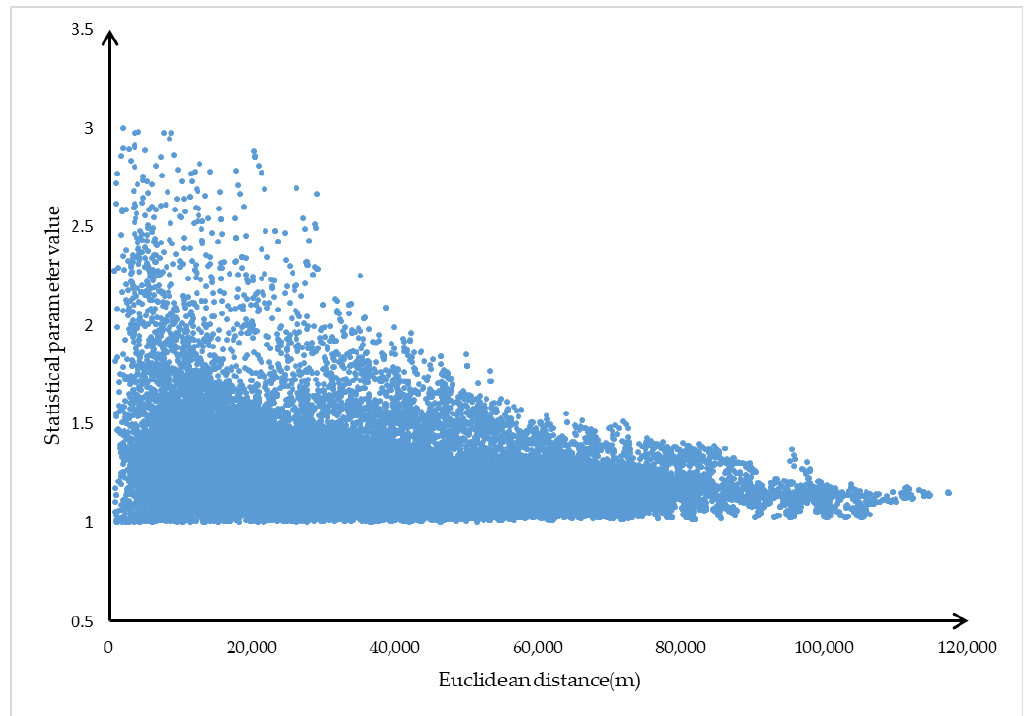
Figure 1. Sample element distribution.